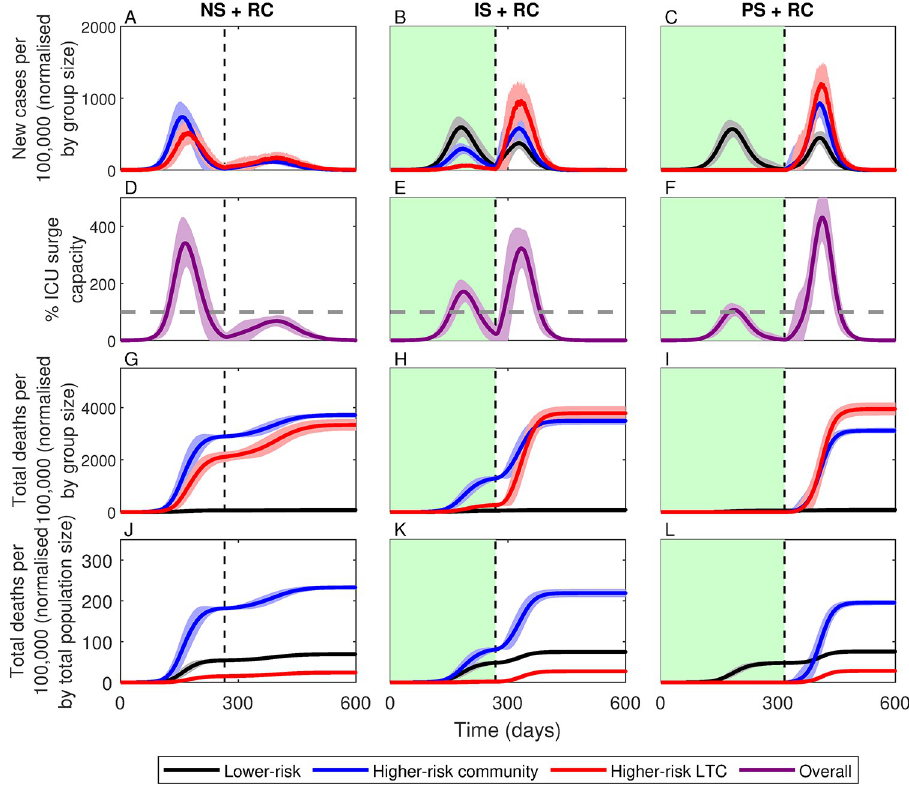
Fig 4. Simulations of the three shielding scenarios with 50% reduced contact (+RC). RC occurs prior to the vertical dashed line. All other descriptions as in Fig 2. Lines correspond to means for groups at: lower-risk (black), higher-risk in the community (blue) and in LTC facilities (red), with shading indicating ± 1 SD. Green shading indicates the shielding phase. NS: no shielding; IS: imperfect shielding; PS: perfect